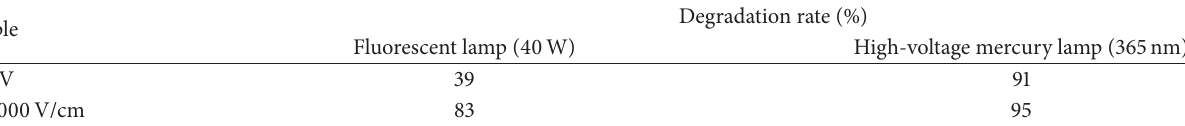
Table 1: Degradation rate of the coextruded film annealed at 500 ∘ C for 3 h: (a) 0V and (b) 6000 V/cm.